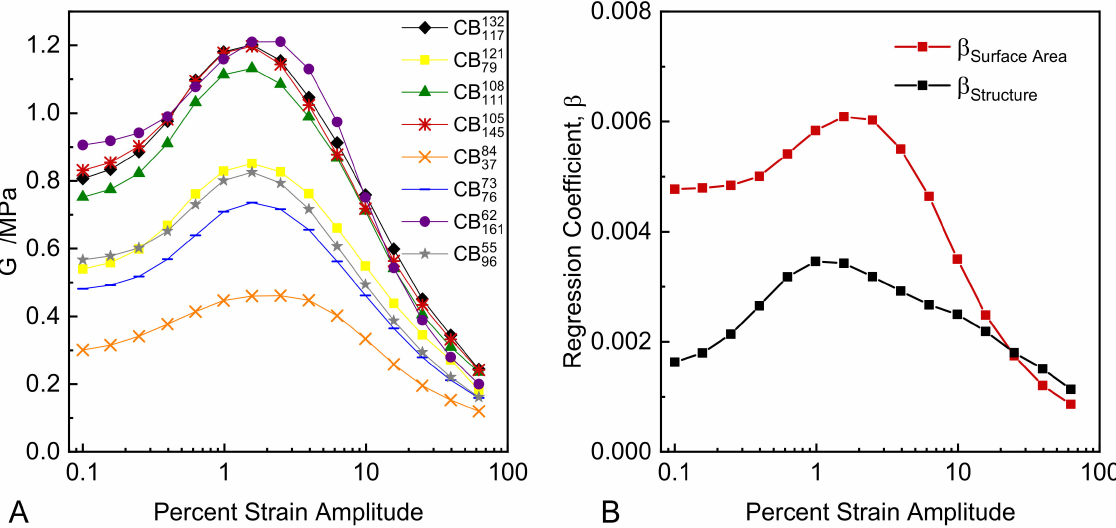
Figure 7. ( A ) G (cid:48)(cid:48) plotted versus strain amplitude; ( B ) multiple regression coefficients for structure and surface area plotted versus strain